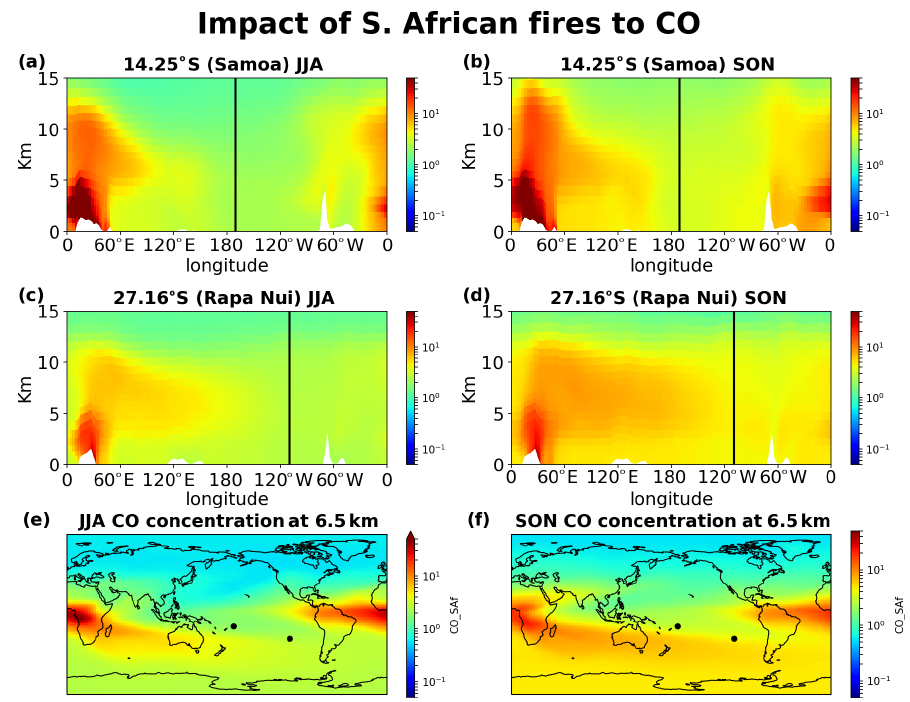
Figure 13. Impact of southern African fires on CO concentrations. (a) JJA and (b) SON 20-year mean impact at the cross section of Samoa, (c) JJA and (d) SON at the cross section of Rapa Nui, and (e) JJA and (f) SON horizontal distribution of the contribution at 6.5km altitude.